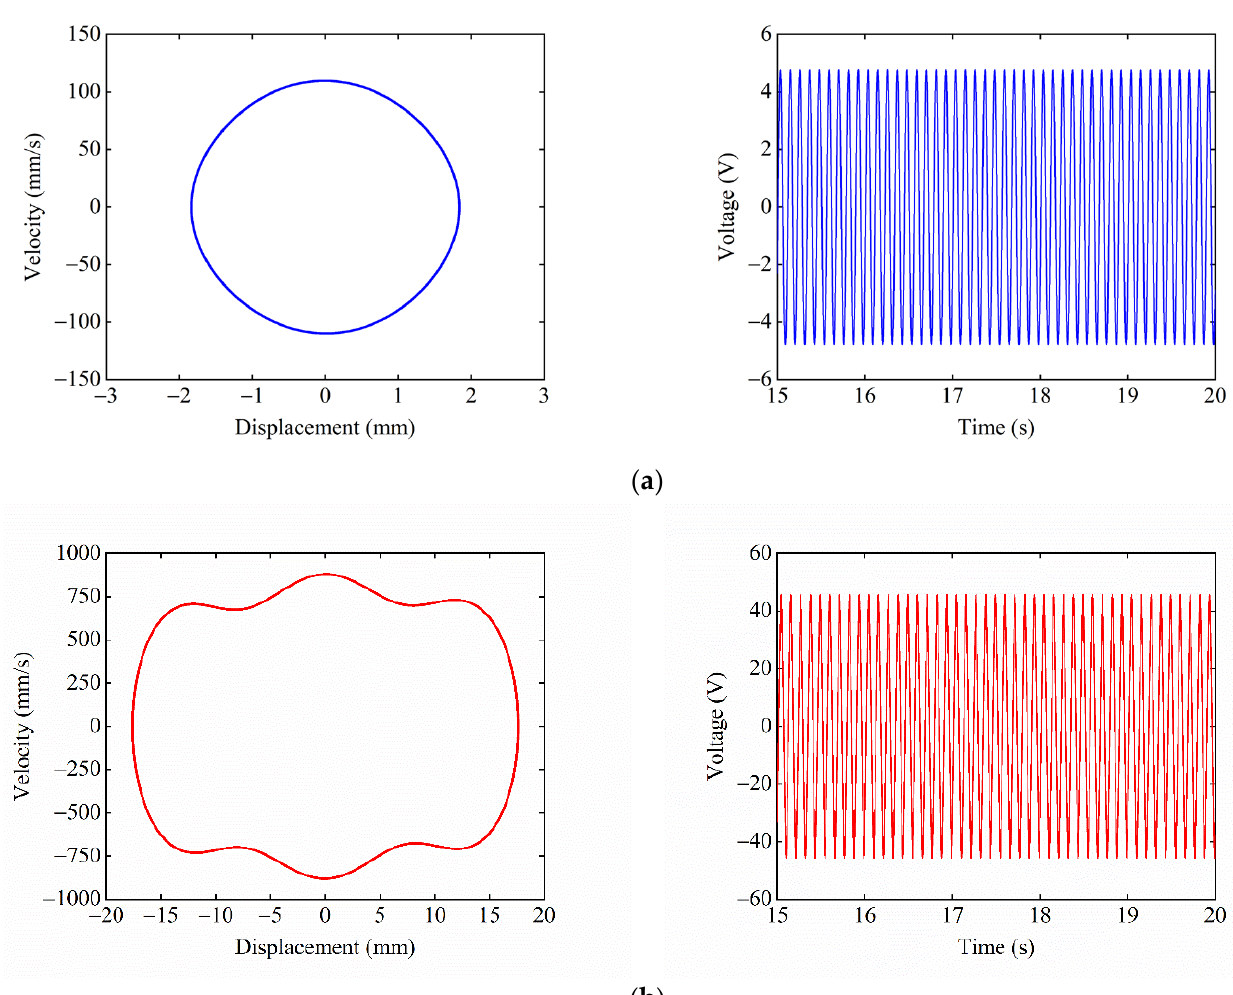
: ( a ) starting po- 𝛥𝛥𝑈𝑈 1 > 𝛥𝛥𝑈𝑈 2